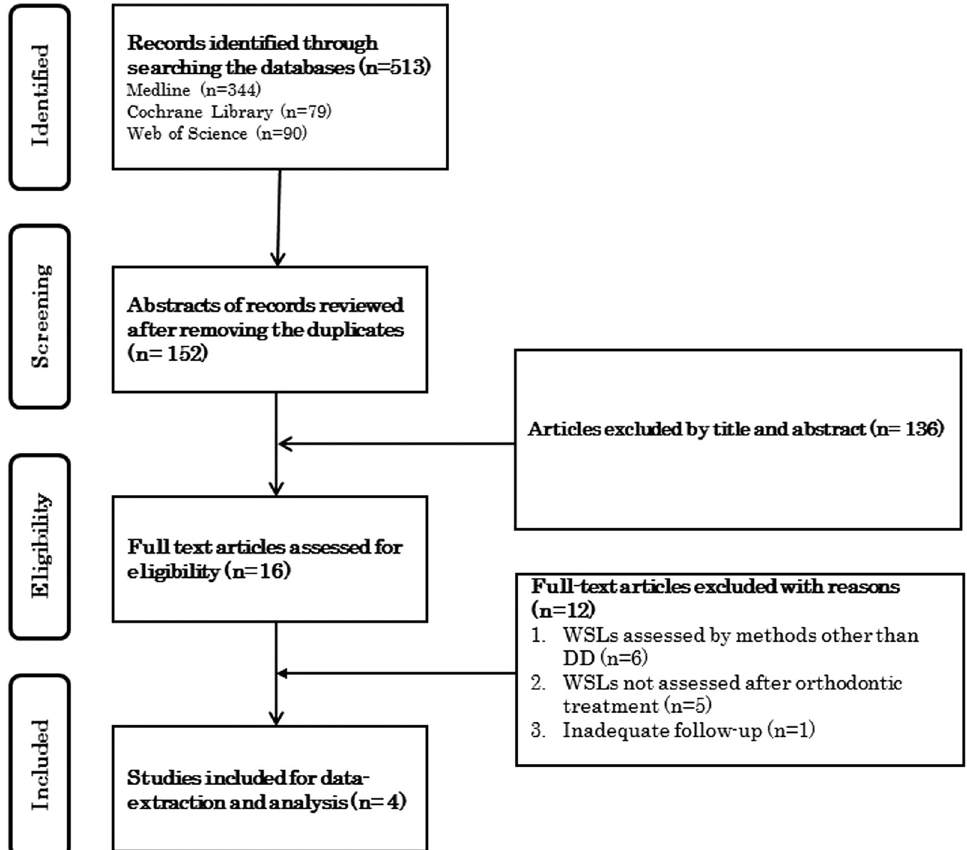
Figure 1. Flow-chart of search and study